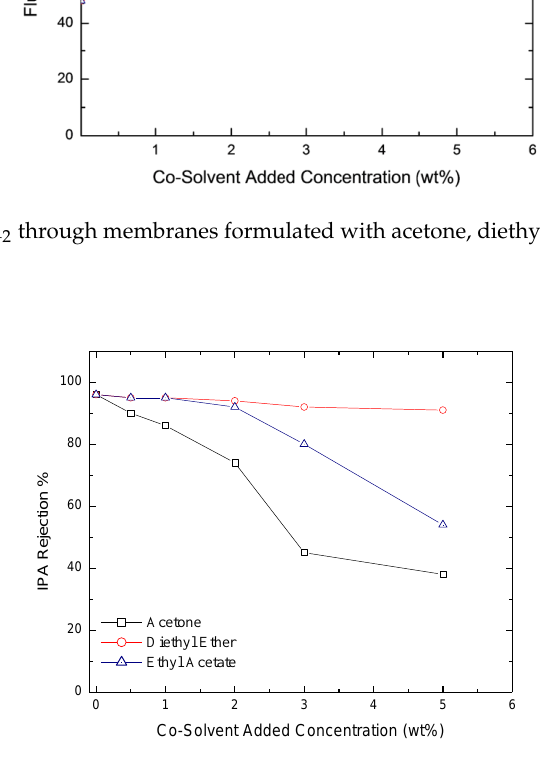
Figure 9. Flux of MgCl 2 through membranes formulated with acetone, diethyl ether and ethyl acetate added as co-solvents.